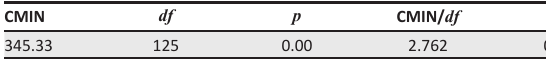
TABLE 5: Measures for goodness-of-fit (structural model).